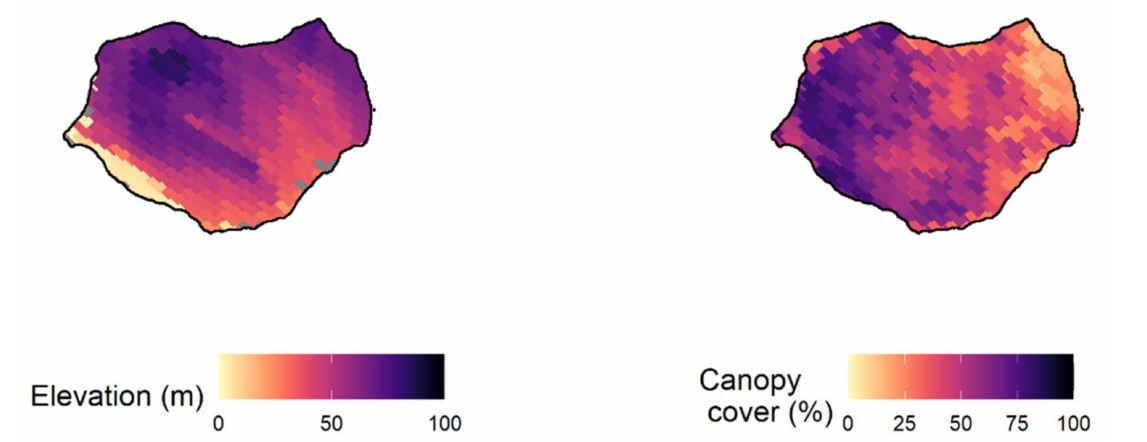
Figure A5. Maps of environmental variables of Mona Island, Puerto Rico. Left: elevation; right: proportion of canopy